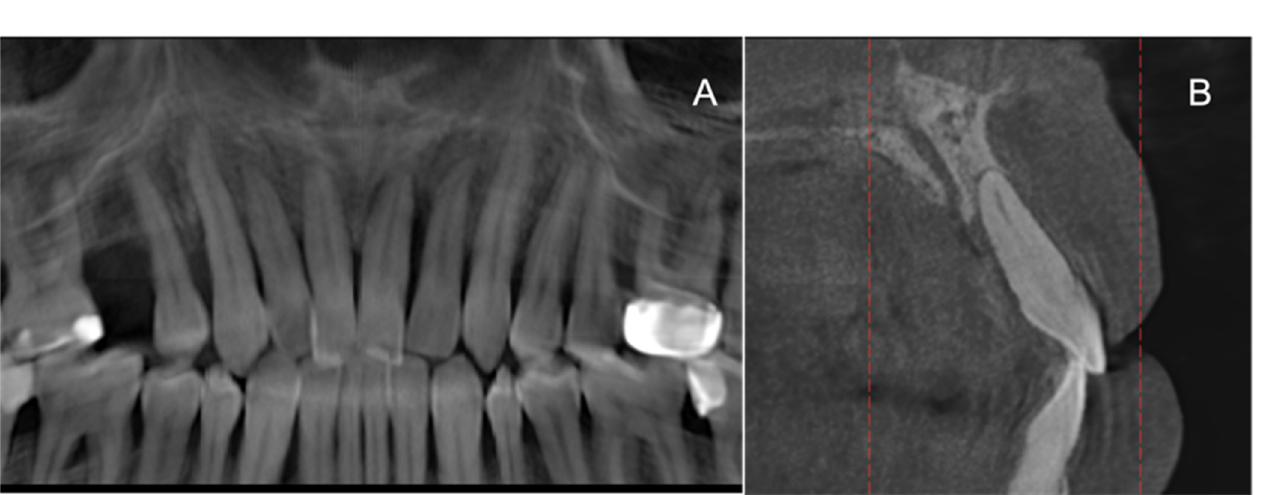
Figure 1. Preoperative radiographic exams: ( A ) OPT; ( B ) CBCT.